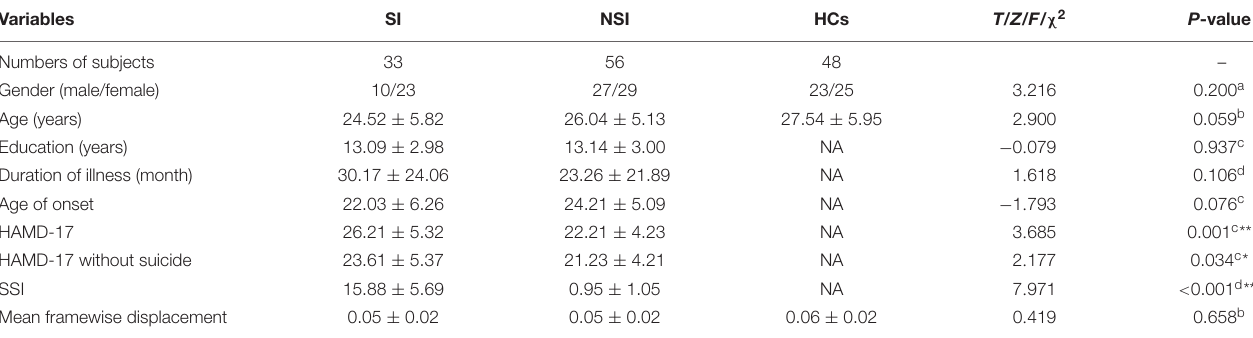
TABLE 1 | Demographic and clinical features of subjects.